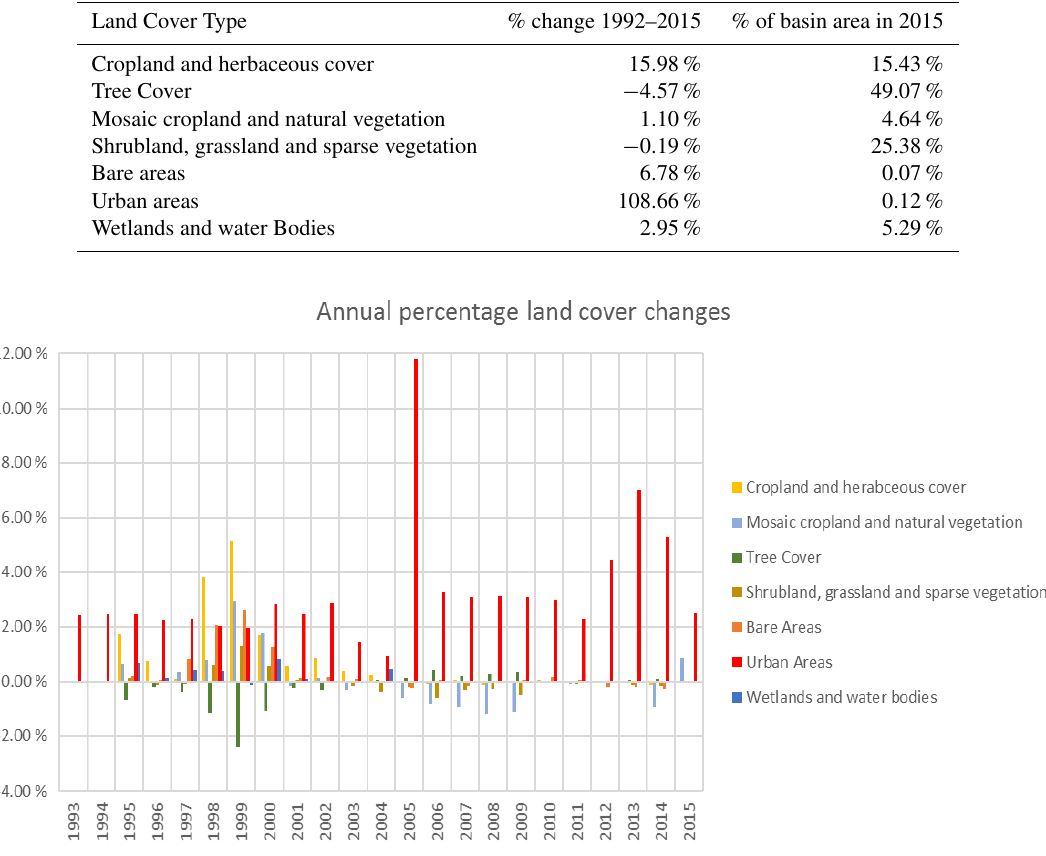
crease in tree cover in the same year, and for the years af- ter, suggesting a regeneration of some of the tree cover that had been cleared earlier for cropland. Urban areas show con- tinued growth throughout the study period, indicating urban expansion in the